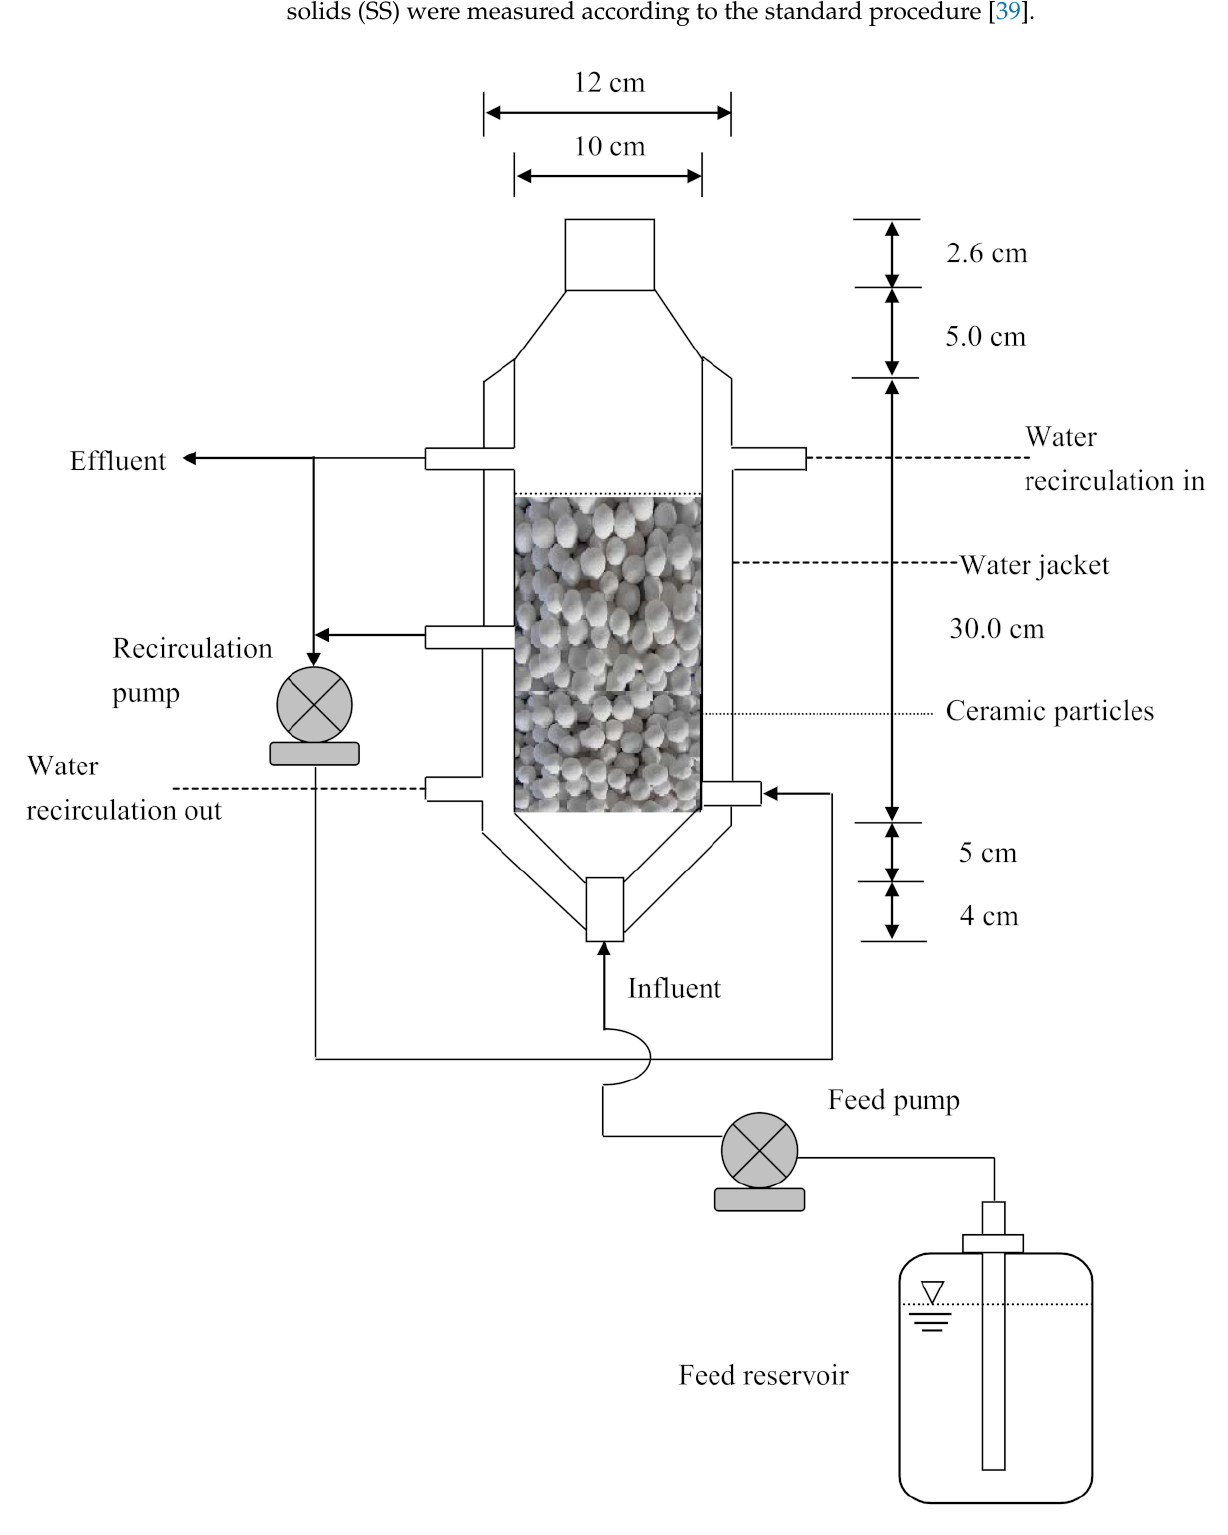
Figure 1. Laboratory-scale packed bed